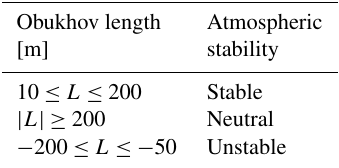
Table 2. Classification of atmospheric stability according to Obukhov length L , based on Peña et al. (2008). The distribution of the atmospheric stability in the measured data can be seen in Figs. 9 and 10.